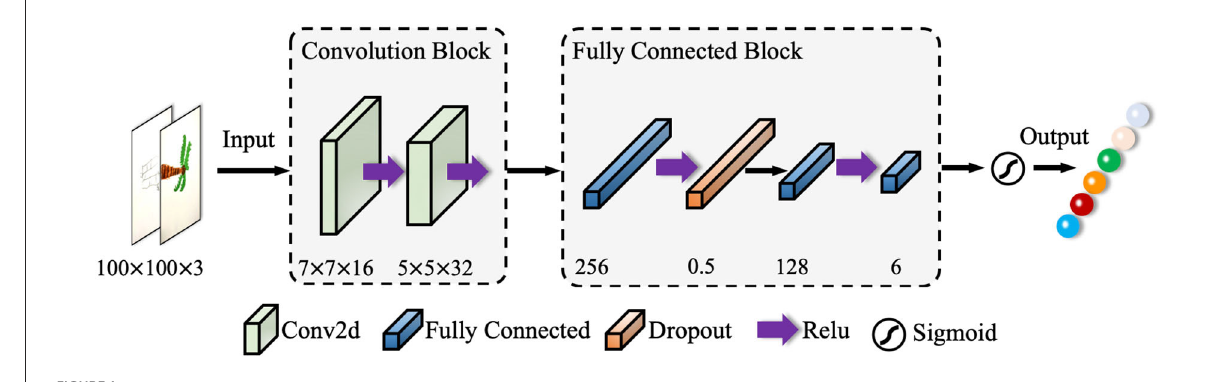
FIGURE1 Structure of the network adopted in this context.